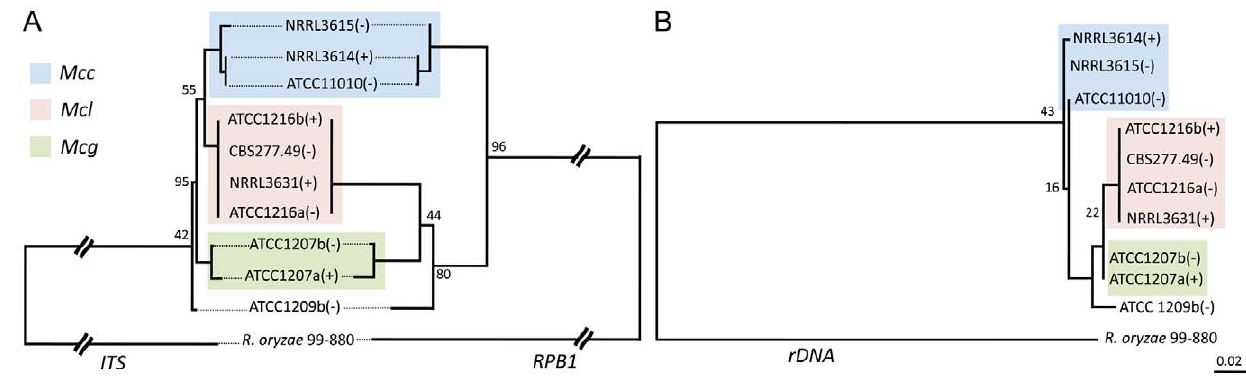
Figure 6. Phylogenetic relationships of the M.circinelloides subspecies. (A) Mucor circinelloides spp. compared with R. oryzae are shown using concatenated RBP1 , rDNA2 , and ITS loci. (B) Phylogenetic relationships constructed with the RBP1 , rDNA2 , and ITS loci in Mcg , Mcc , and Mcl . Both phylogenetic analyses provide evidence that there are three subspecies within the M. circinelloides complex. Mcc : M. circinelloides f. circinelloides , Mcl : M. circinelloides f. lusitanicus , and Mcg : M. circinelloides f. griseocyanus